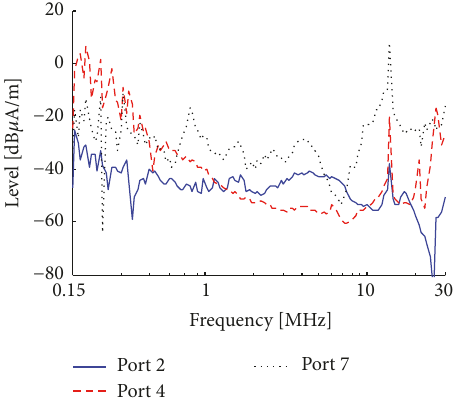
Figure 9: EMI from the three maximum components.